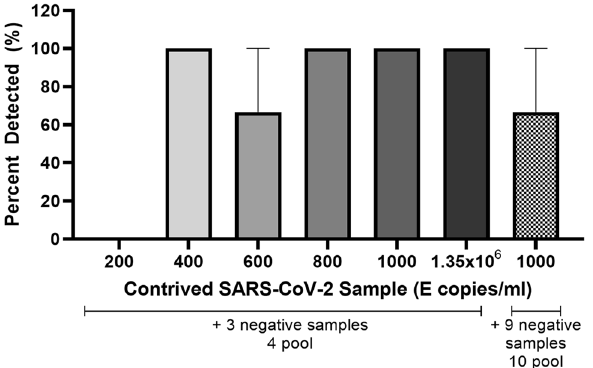
Figure 1. Sensitivity of the FilmArray RP2.1 for the detection of SARS-CoV-2 after specimen pooling. One contrived sample containing, 200, 400, 600, 800 or 1000 E copies/ml, was equally mixed with three negative contrived samples, with the exception of the last sample, which was equally mixed with nine negative contrived samples. The FilmArray RP2.1 was used to detect the presence of SARS-CoV-2. Each bar denotes a separate pool. Each pool was tested in triplicate and the mean and standard error are